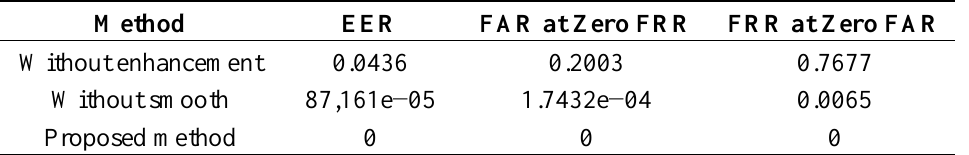
Table 2. Verification performance of different